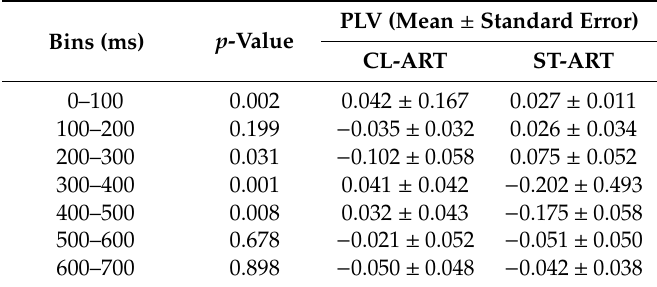
Figure 3. ( a ) The group grand average for P3b captured before and after the two kinds of ART interventions; ( b ) paired t -test and subject means for P3b; ( c ) scatter plots for RT di ff erence and P3b di ff erence. Table 3. Summary of one-way ANOVA analysis results for ITC( θ ) di ff